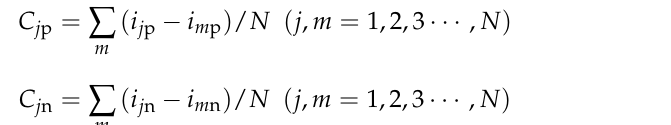
Figure 6. DC equivalent circuit, figures ( a – f ) show six circulation paths respectively. According to the definition of the circulating current of the paralleled converter, the circulating current is the output voltage difference of the paralleled modules divided by the number of paralleled modules. When the three-phase current source converters are connected in parallel, the circulating current flowing through the positive DC bus of module j is shown in Equation (1), and the circulating current flowing through the negative DC bus of module j is shown in Equation (2).